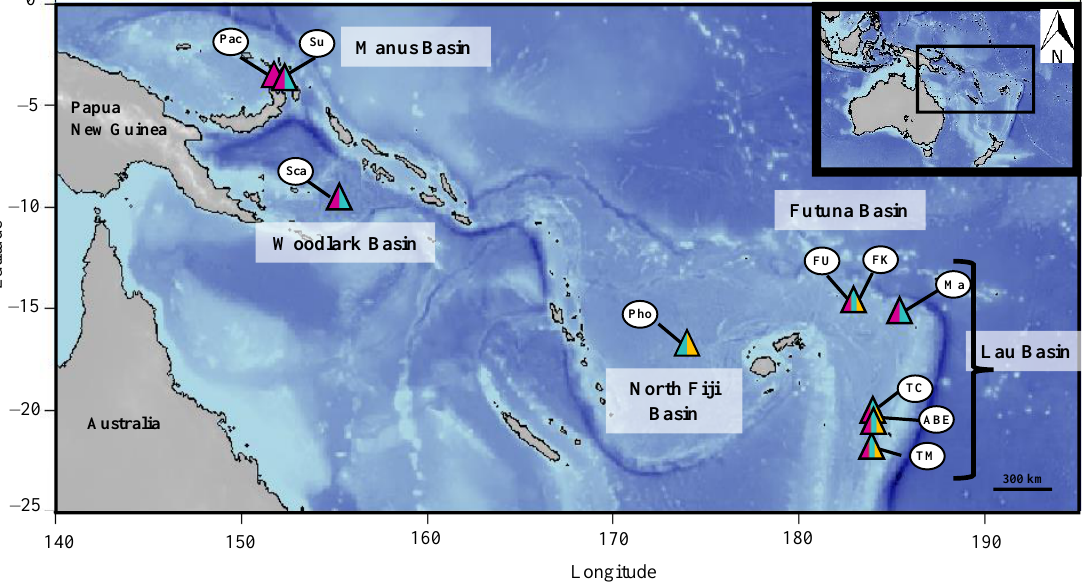
Figure 1. Sampled localities of Alviniconcha species during the Chubacarc expedition. Manus Basin: Susu (Su); Pacmanus (Pac). Woodlark Basin: Scala (Sca). North Fiji Basin: Phoenix (Pho). Futuna